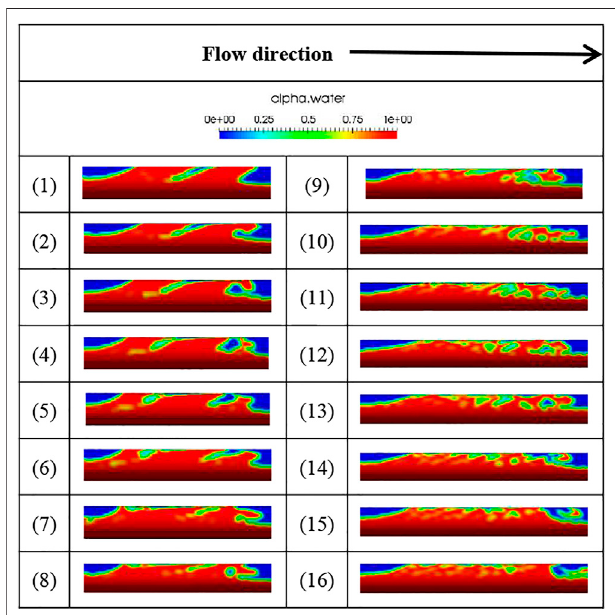
FIGURE12| Liquidholdupdistributionofadevelopingslug( V sg (cid:2) 2 m/s, V sl (cid:2) 1 m/s).